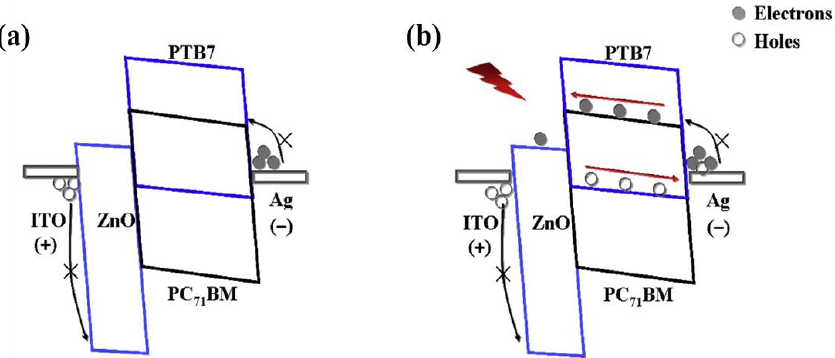
Figure 9. Working mechanism of the OPDs based on PTB7:PC71BM with the ZnO electrode buffer layer under bias: ( a ) in the dark; ( b ) under illumination. (Reproduced with permission from [83]. ELSEVIER Publishing, 2014).